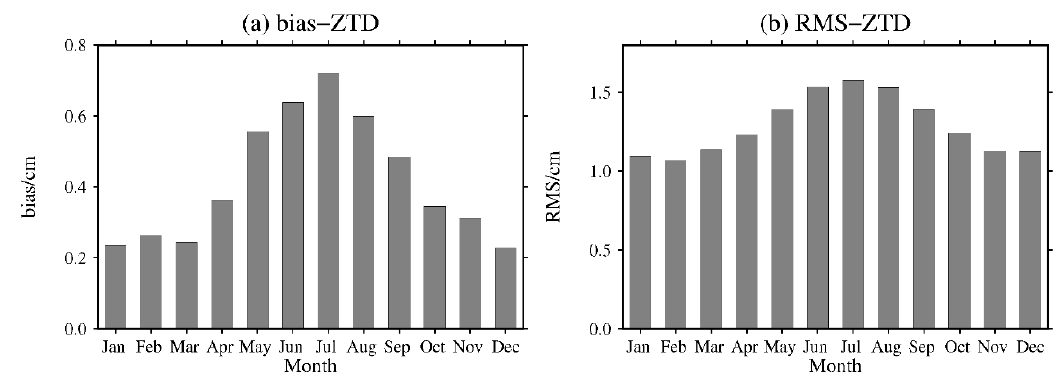
Figure 6. Monthly average ( a ) bias and ( b ) RMS of the MERRA-2 ZTDs at 316 GNSS stations worldwide in 2016.